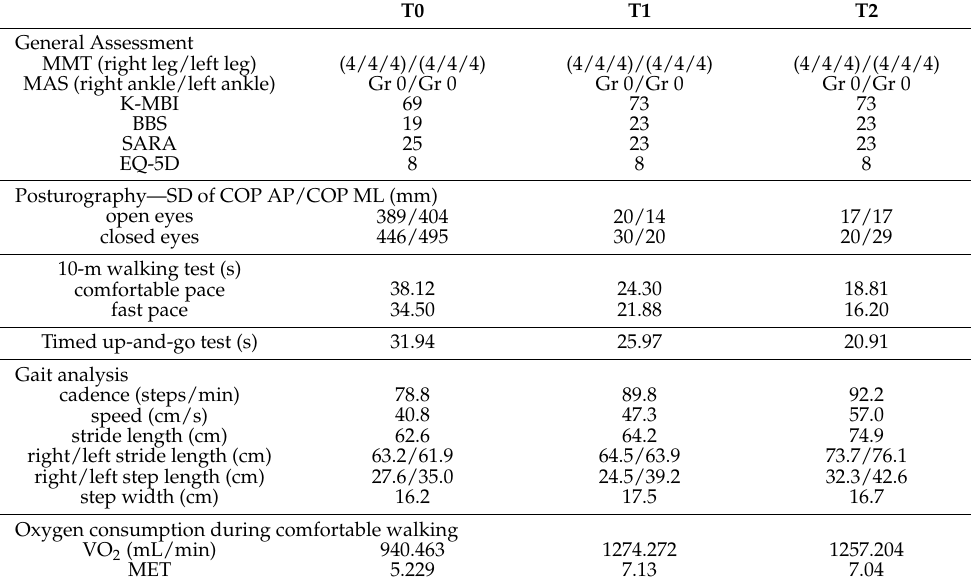
Table 1. Functional